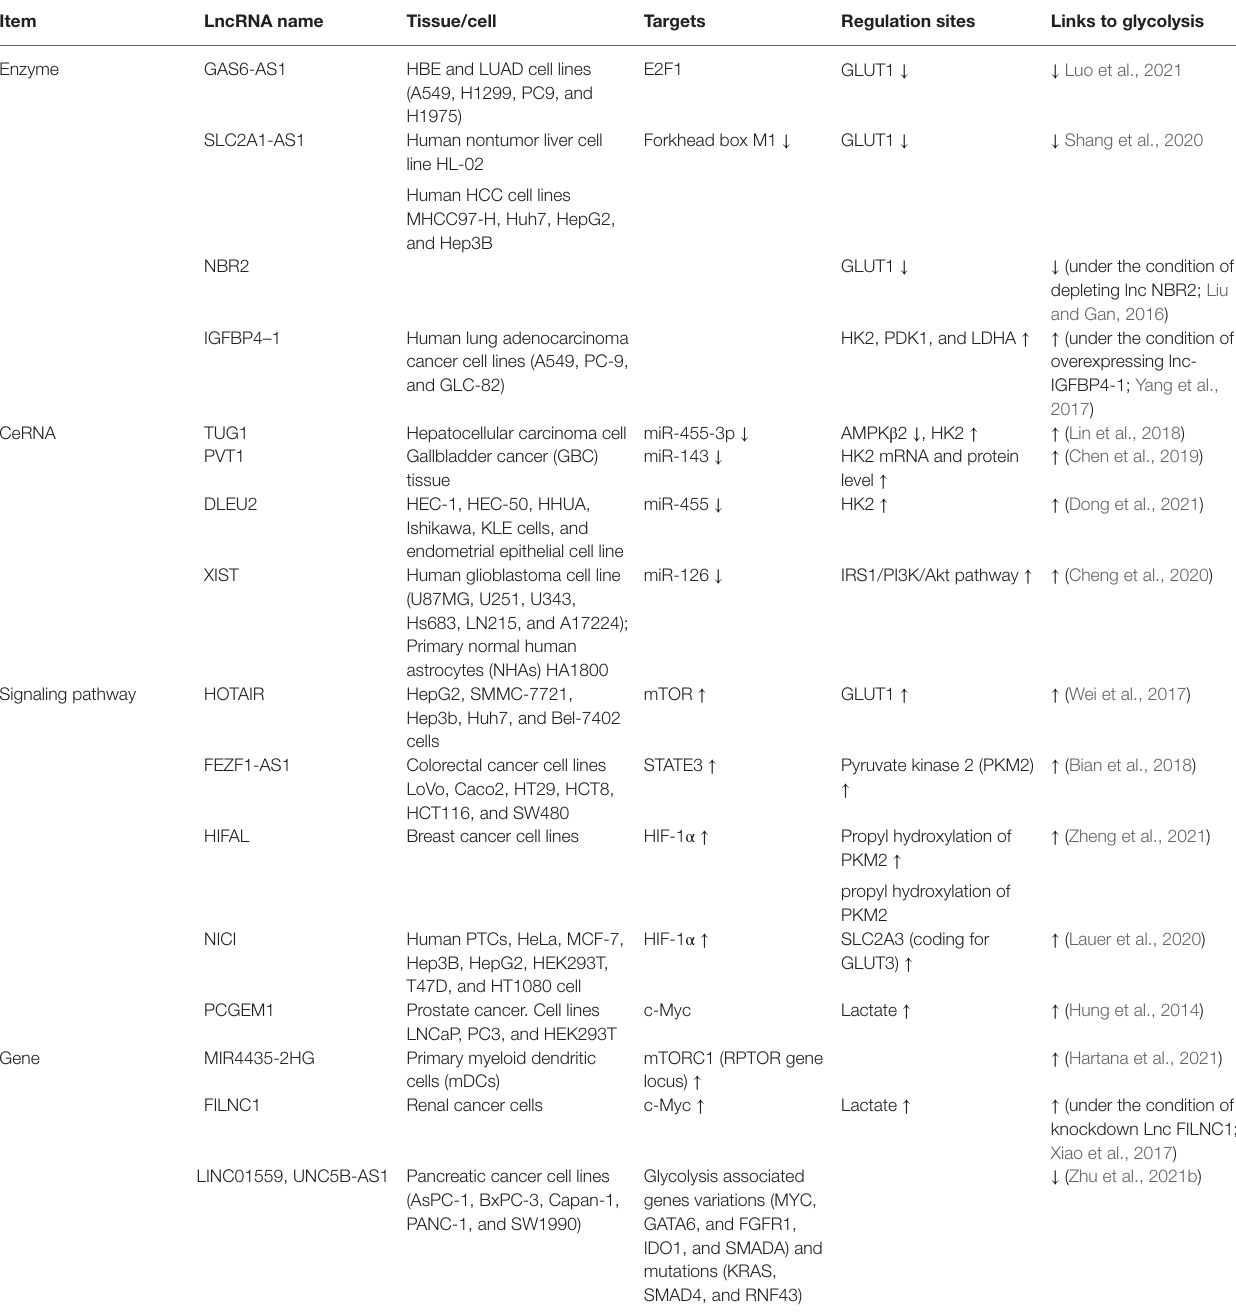
TABLE 1 | Long noncoding RNA (LncRNA) links glycolysis.